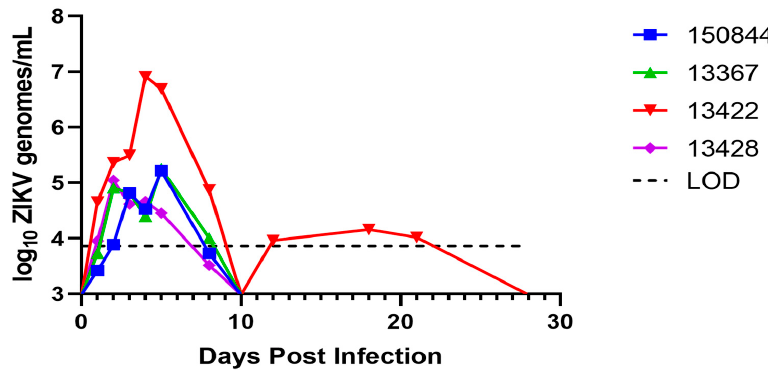
Figure 2. Whole blood viral load. Results of iTaq One-Step qRT-PCR to determine whole blood viral load in each animal on the specified day through conversion to genome copies/mL by standard curve. Macaque 150844 seen in blue, 13367 in green, 13422 in red and 13428 in purple. Limit of detection for the assay demonstrated at ≈ 3.9 genome copies/mL based on a ≈ 100 genome/mL whole blood detection limit and 140 µ L extraction from whole blood.